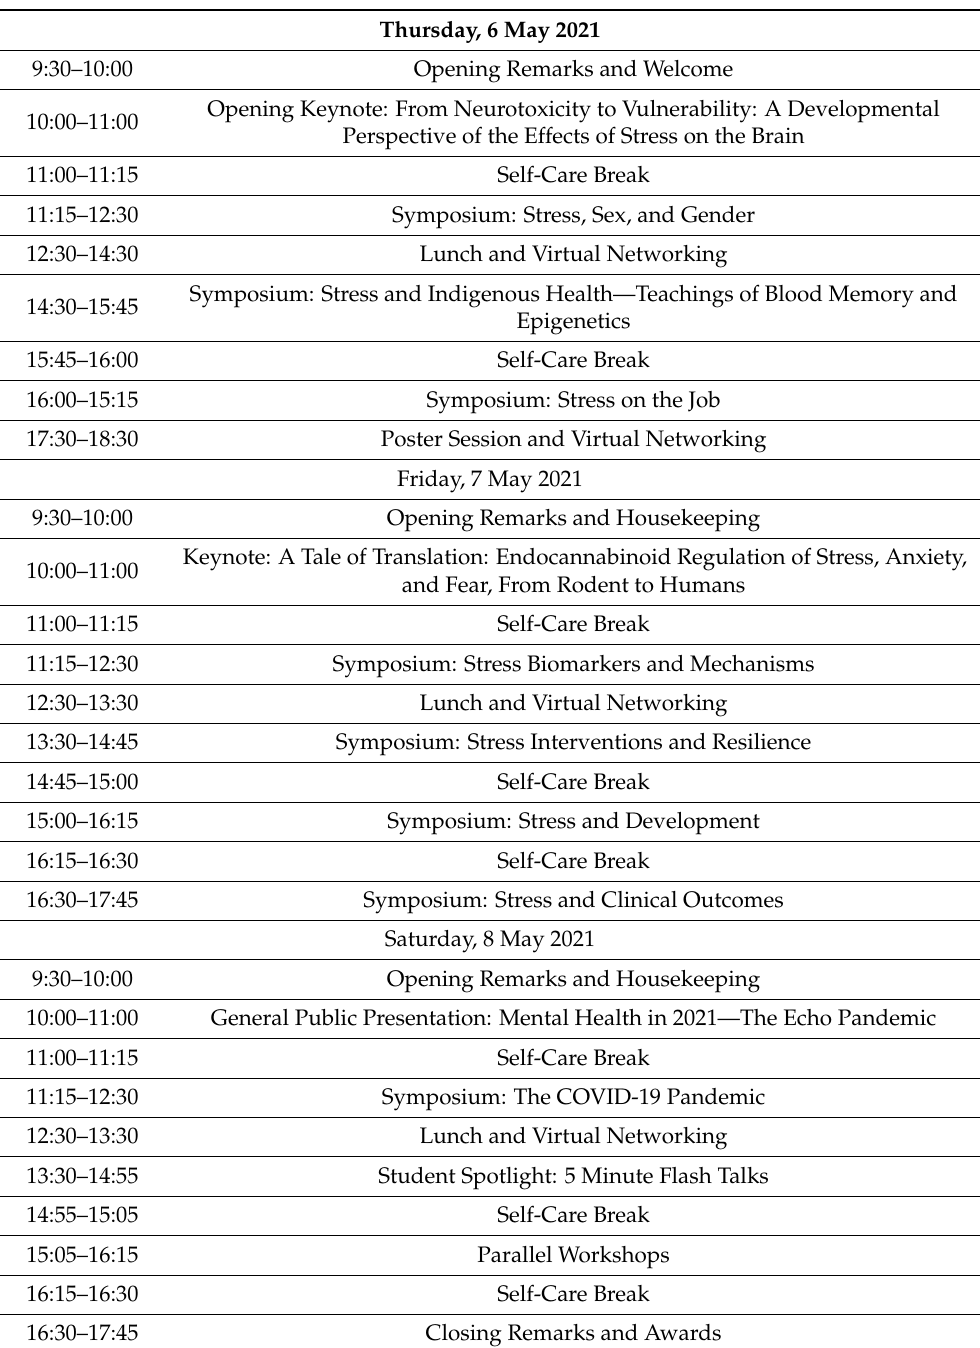
Table 1. Overview of the conference